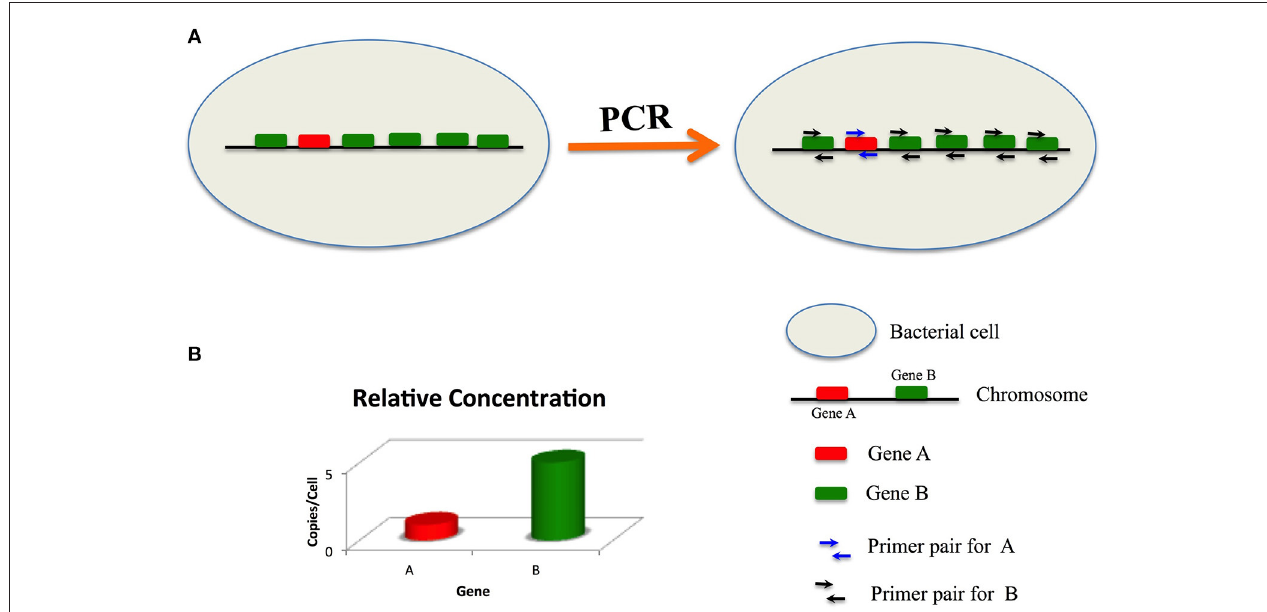
FIGURE 1 | Principle of sensitive detection by targeting multi-copy signature genes. In a bacteria cell, there is one copy of gene (A) and five copies of gene (B) primers for gene (A) have only one binding site, while primers for gene B have five binding sites. If the amplification efficiencies of (A) and (B) are identical, then the sensitivity of detection of gene (B) is five times that of gene (A)